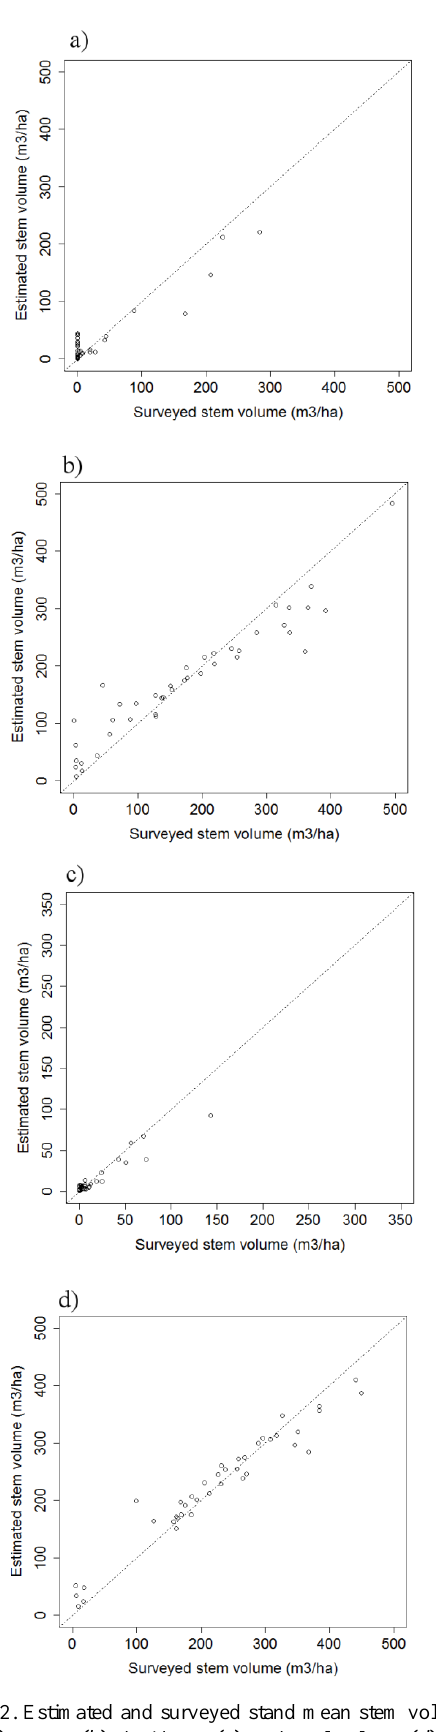
Figure 2. Estimated and surveyed stand mean stem volume, for pine ( a ), spruce ( b ), deciduous ( c ), and total volume ( d